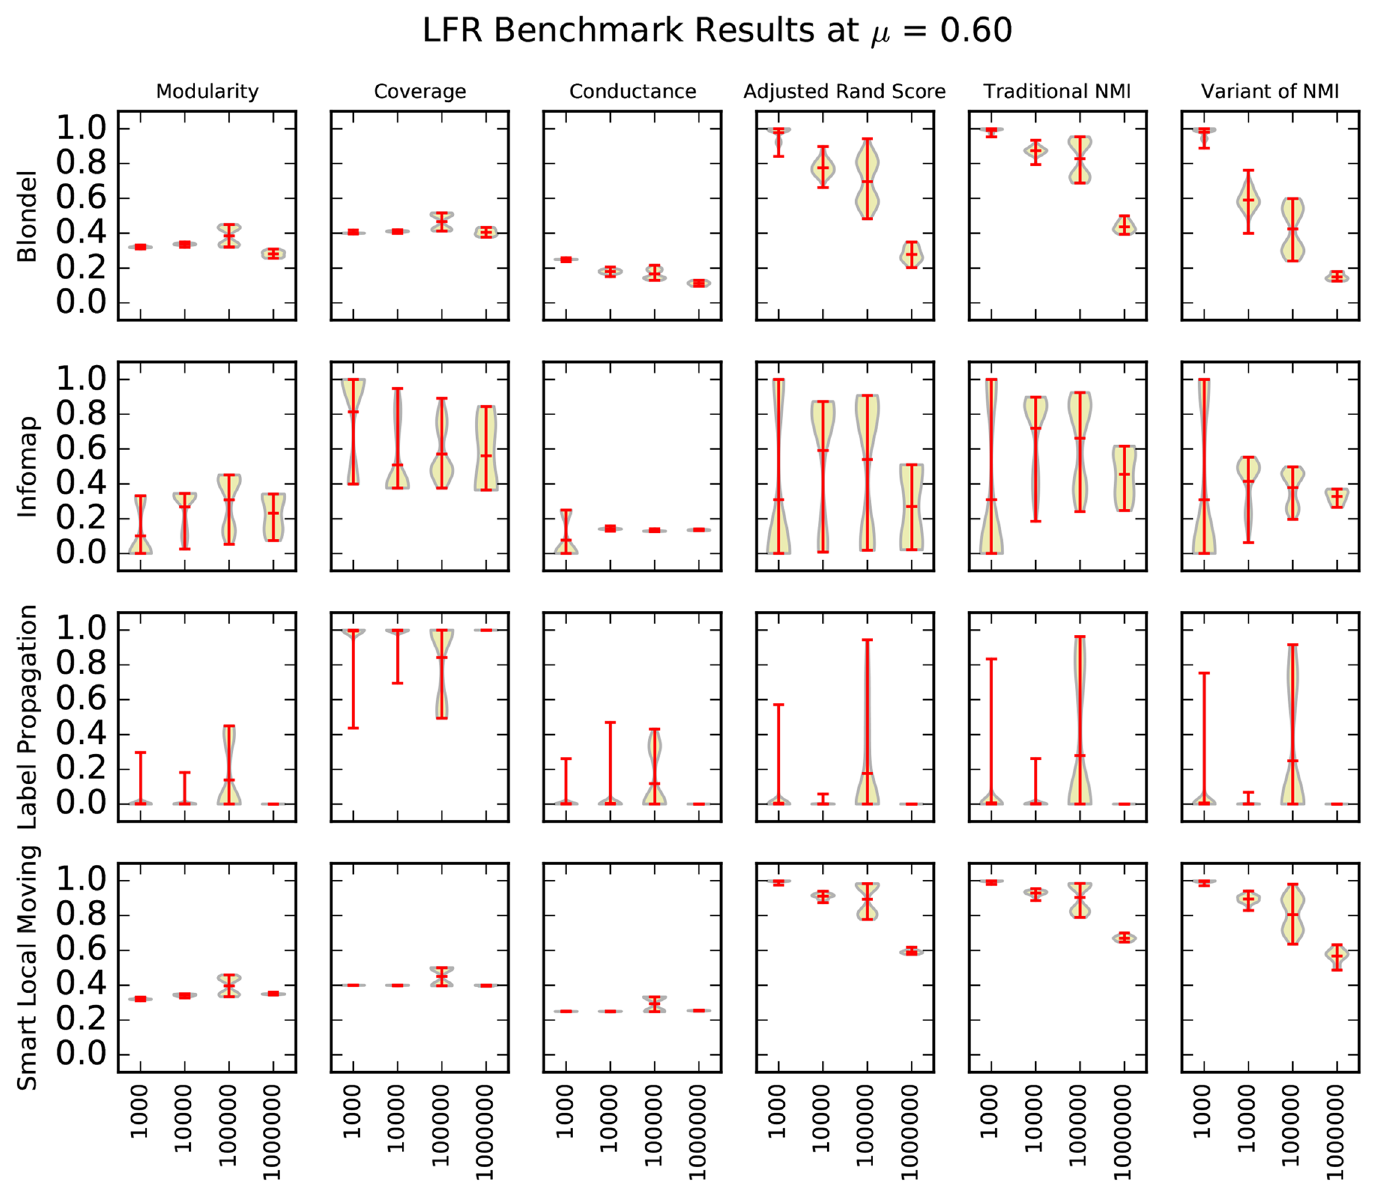
Fig 6. A matrix of violin plots illustrating the synthetic graph experiment results at μ = 0.60. We drew each “ violin ” using a Gaussian kernel density estimation. Red lines indicate the minimum, maximum, and mean of the